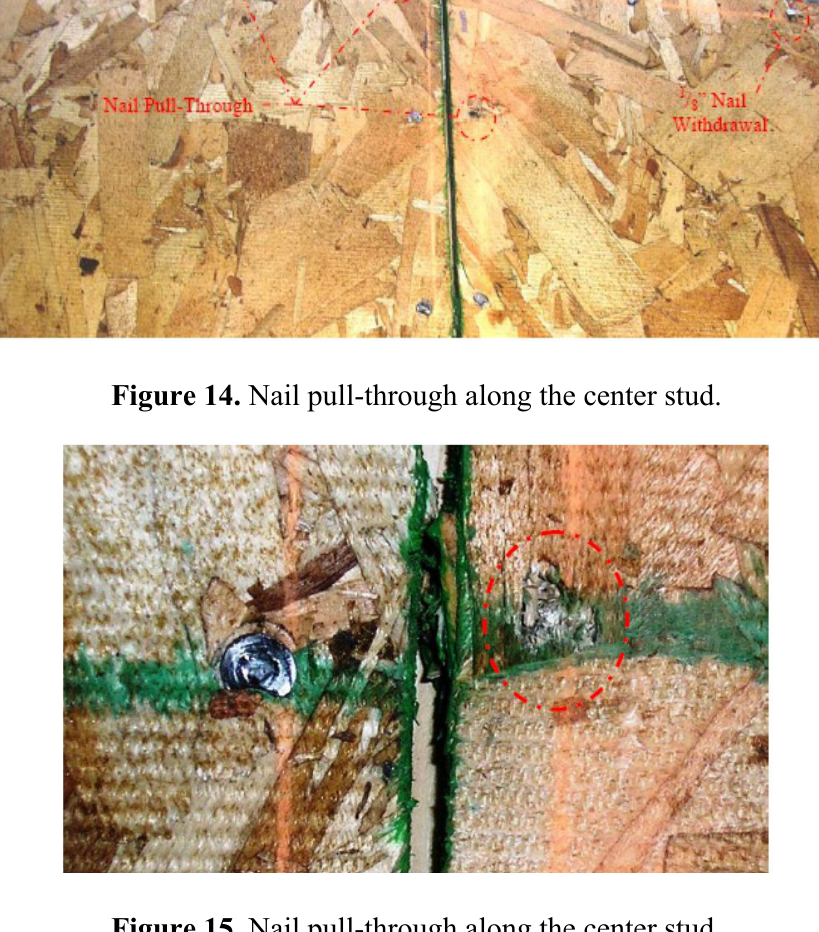
Figure 15. Nail pull-through along the center